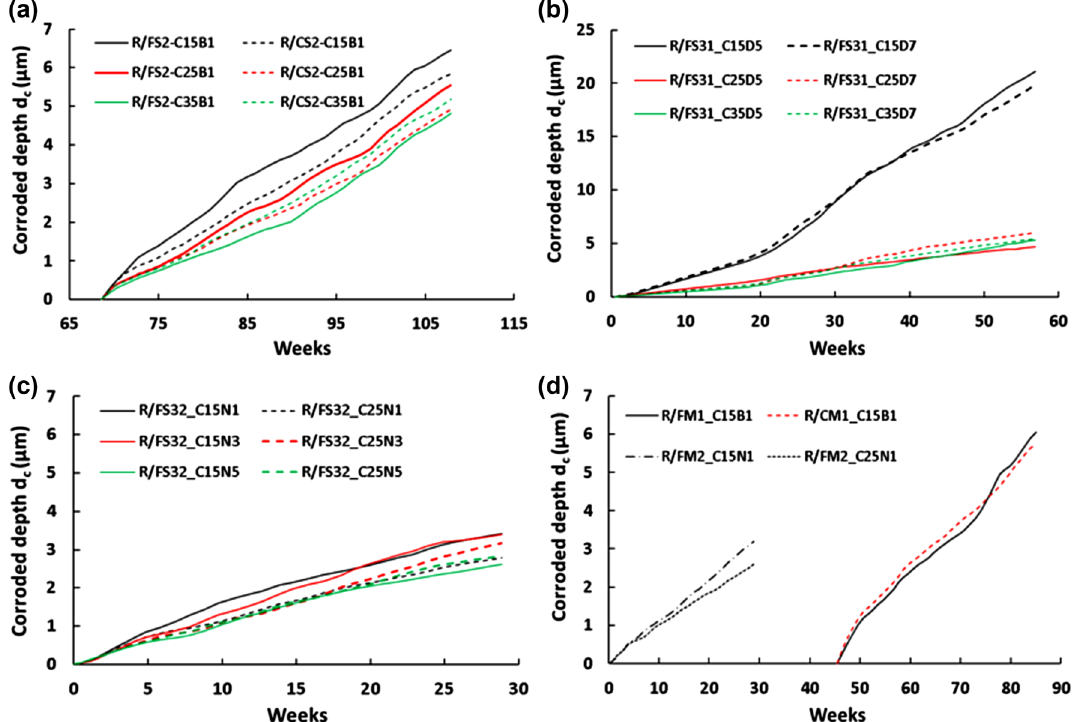
Fig. 4 Obtained corroded depths of steel bars in different R/SHCC and R/mortar specimens in accelerated corrosion